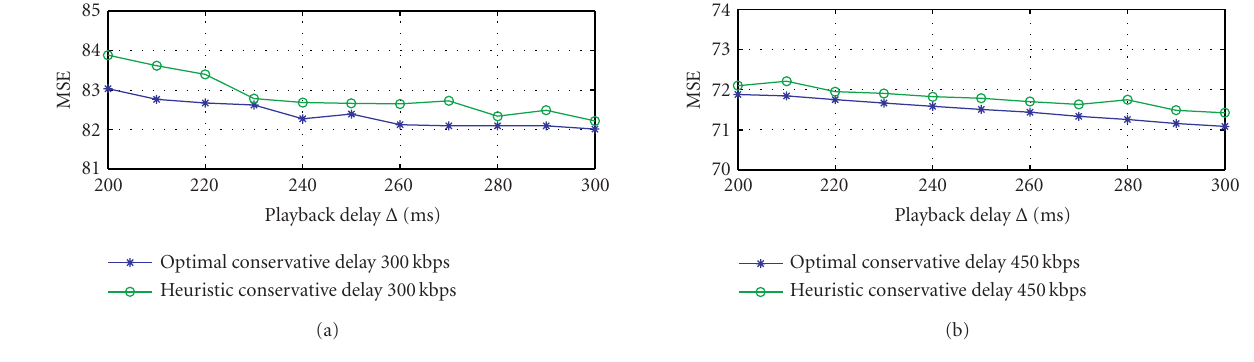
Figure 8: Quality evaluation for scheduling with heuristic and optimal δ for ns-2 network rate